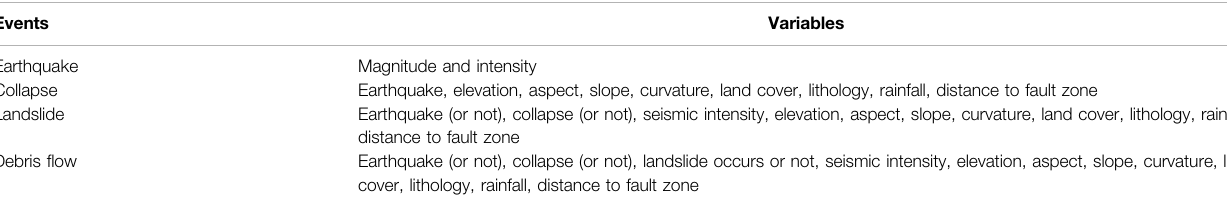
TABLE 3 | Variables of earthquake disaster